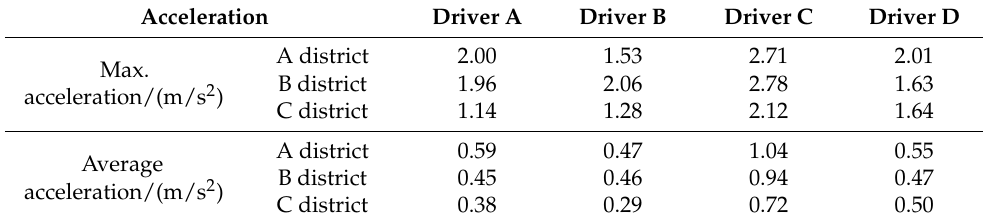
Table 5. Acceleration from different